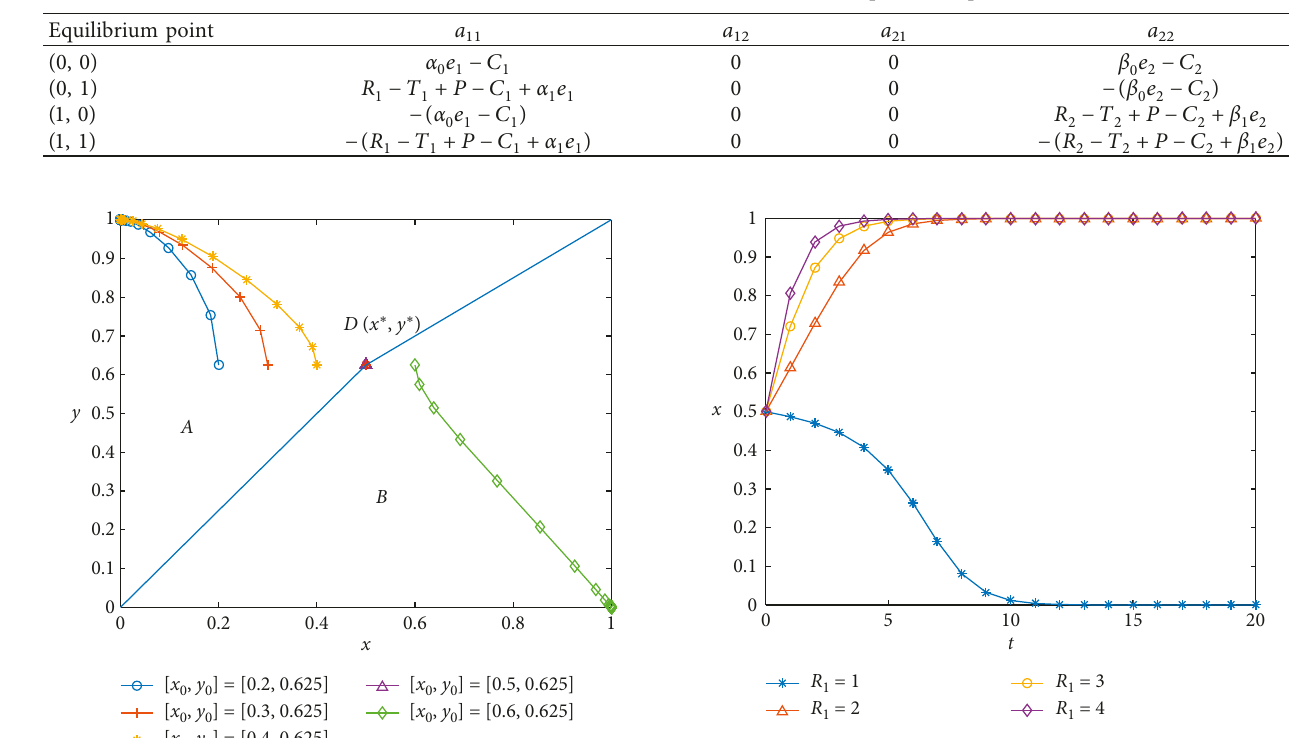
Figure 4: Influences of the profit R 0 on the